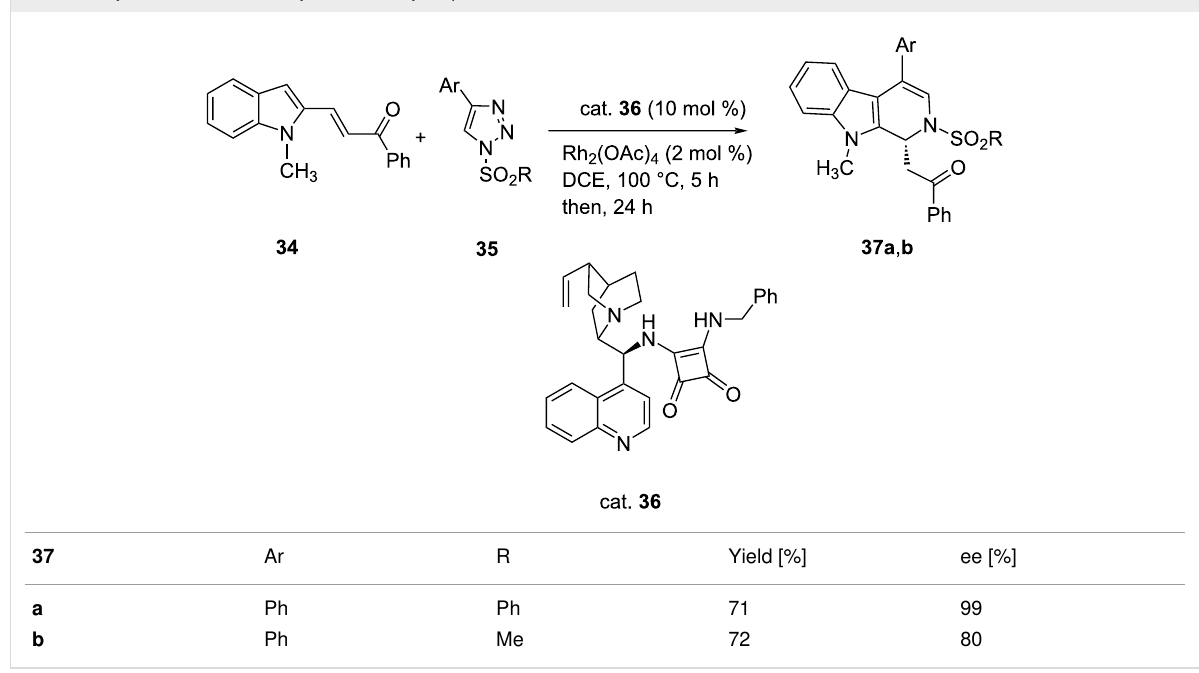
Table 7: Asymmetric aza-Michael synthesis of dihydro- β